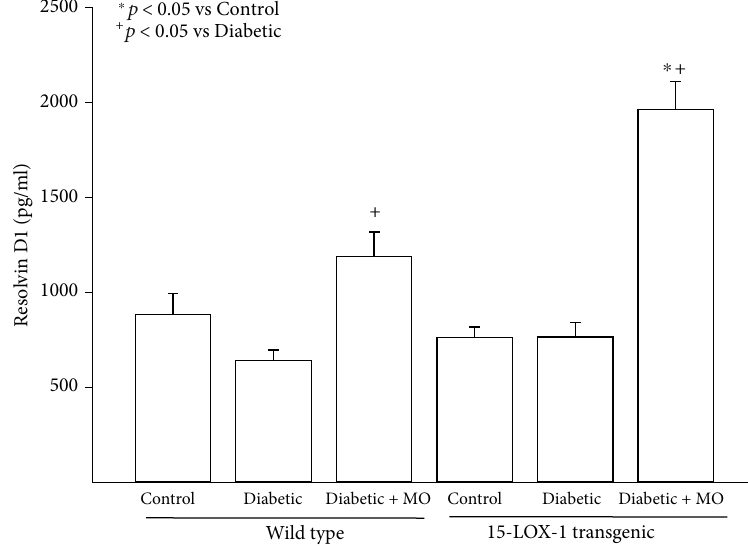
Figure 2: Treatment with menhaden oil of type 2 diabetic wild-type and 15-LOX-1 transgenic mice: e ff ect on serum resolvin D1 levels. Serum resolvin D1 levels were determined as described in Section 2. Data is presented as mean ± SEM in pg/ml. The number of mice in each group was the same as presented in Table 1. ∗ p < 0 : 05 compared to their respective control mice; + p < 0 : 05 compared to their respective untreated diabetic